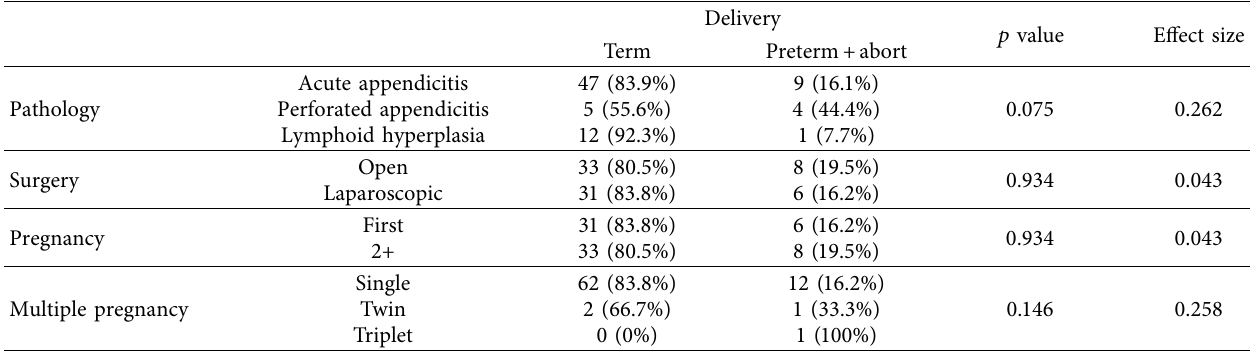
Table 4: Relation of various states with delivery.